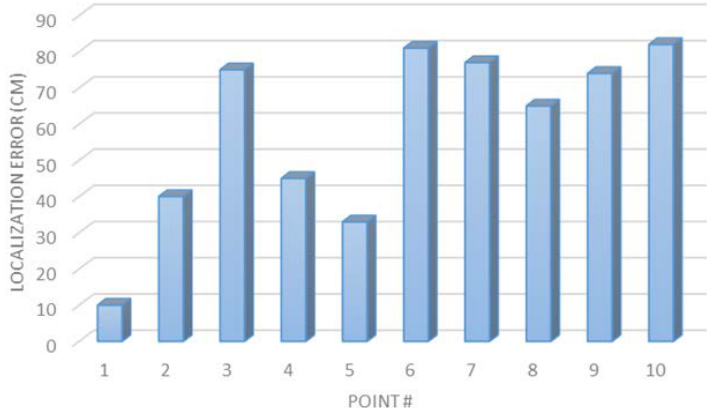
Figure 12. The localization error for the robot system in Area 2 for 10 different positions.